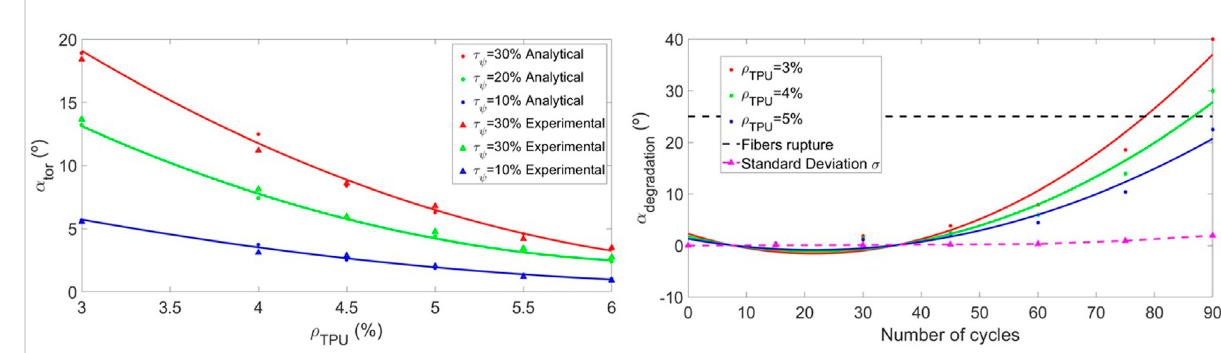
cycles . The magenta dashed